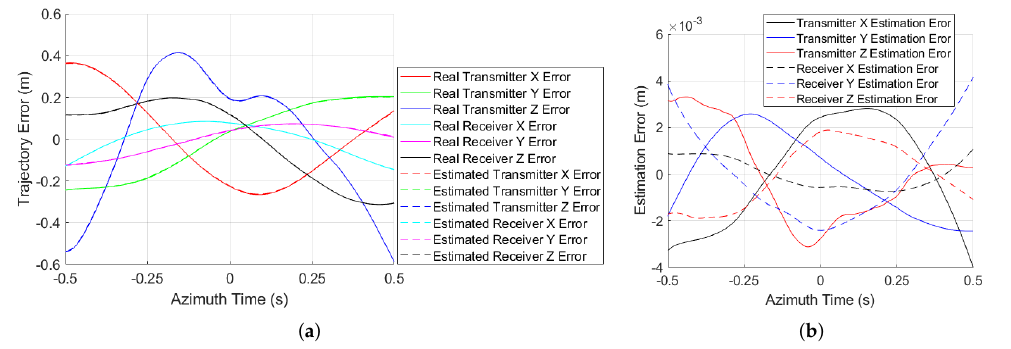
Figure 11. Trajectory error estimation performance: ( a ) trajectory error estimation results; ( b ) error of trajectory error estimation.